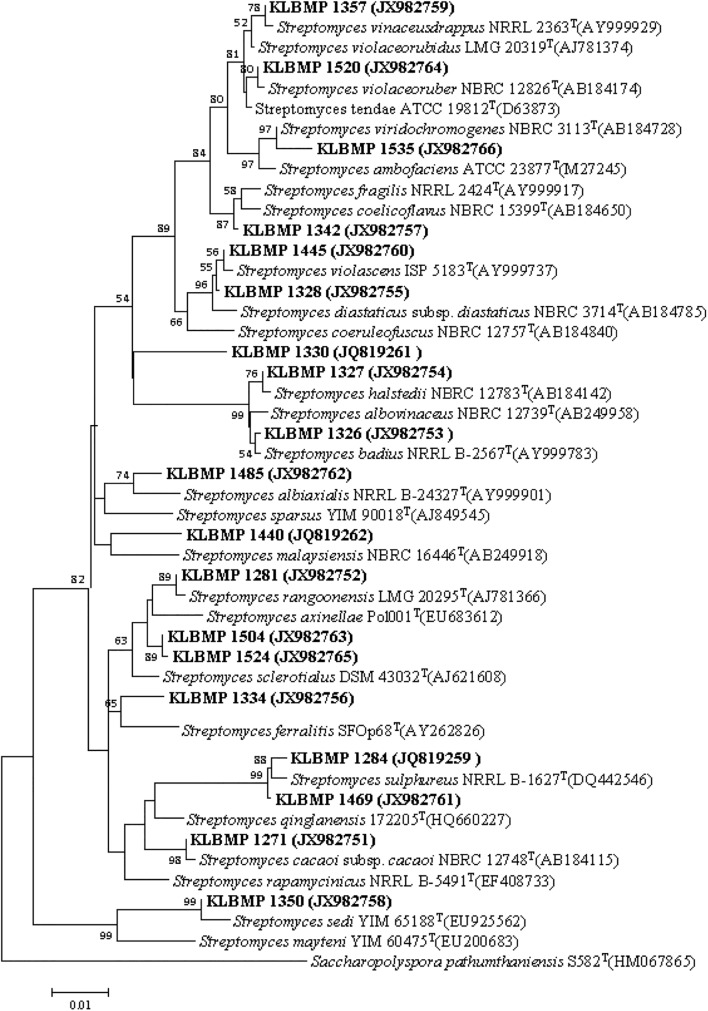
Neighbor-joining phylogenetic tree of 16S rRNA gene sequences obtained from Streptomyces isolates in this study and their phylogenetic neighbors. Only bootstrap values above 50% are shown at nodes and are expressed as percentages of 1,000 replicates. Bar represents 0.01 substitutions per nucleotide position. GenBank accession numbers of reference 16S rRNA gene sequences are shown next to isolate names. Saccharopolyspora pathumthaniensis S582T (HM067865) was used as the outgroup.